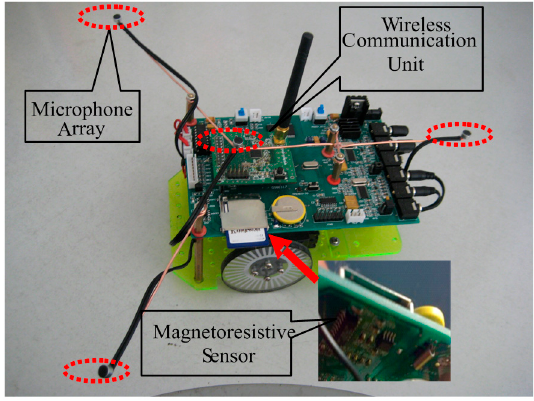
Figure 2. Photograph of a mobile robot.